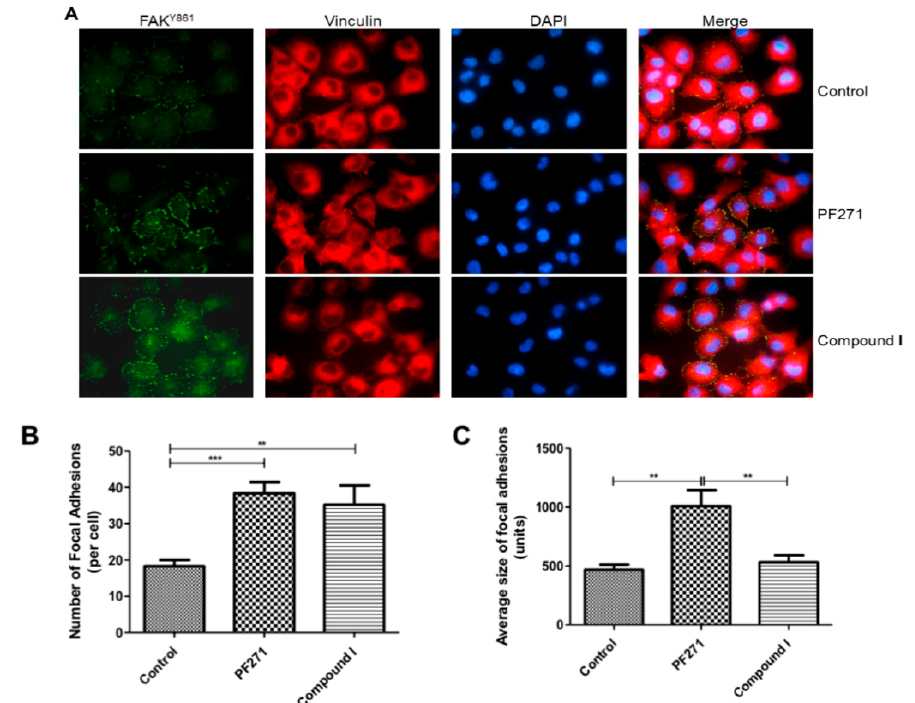
Figure 8. Exploration of subcellular dynamic changes in active FAK and FA-marker vinculin following compound I or PF271 treatment. ( A ) Images are representative of MDA-MB-231 cells following 1 h of serum stimulated migration in the presence of compound I, PF271, or a vehicle-only control. The generated images were subsequently used to quantify changes in the average number of focal adhesions / cell ( B ) and the average size of focal adhesions ( C ). All error bars represent SEM; n = 3. ** p < 0.01; *** p <